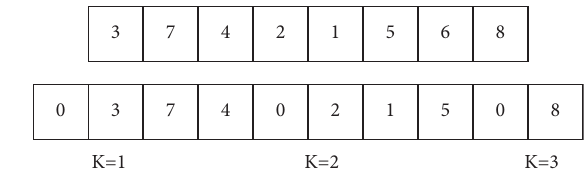
Figure 9: Schematic diagram of the encoding mode.